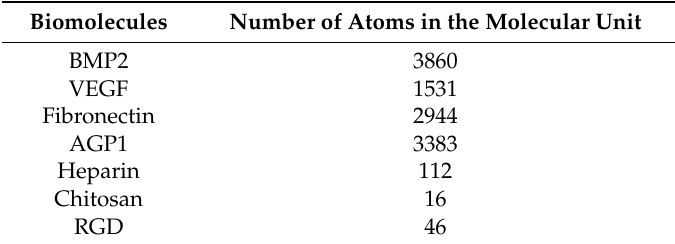
Table 2. Number of atoms for the biomolecules BMP2, VEGF, fibronectin, AGP1, heparin, chitosan and